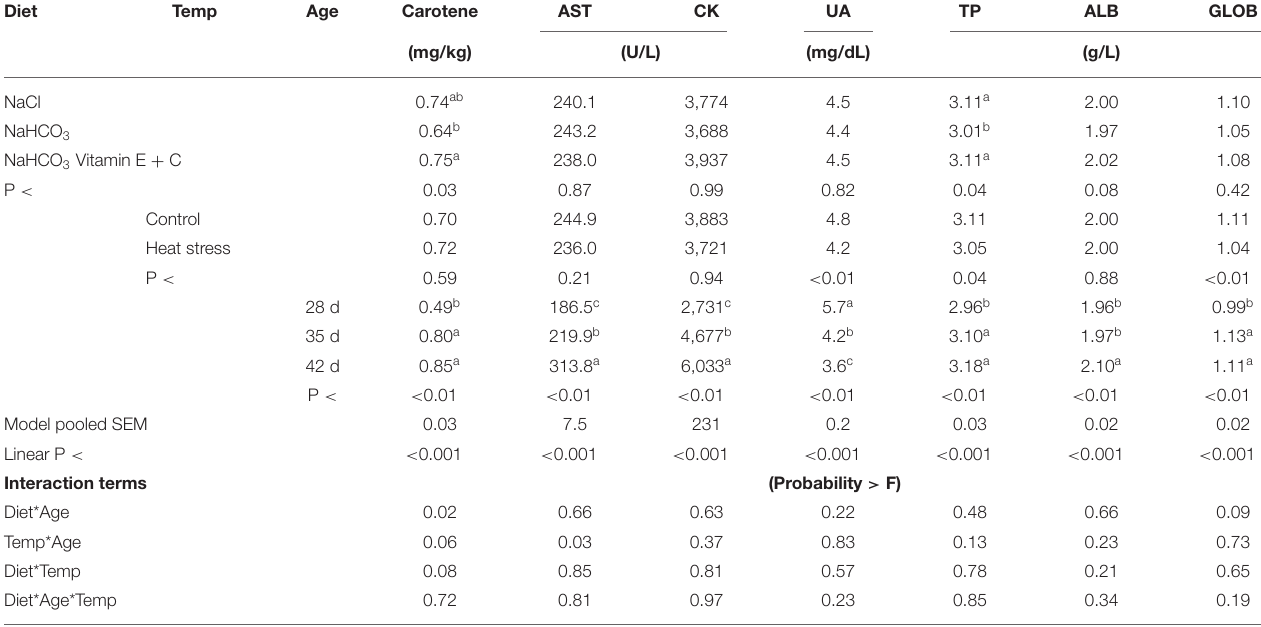
TABLE 4 | Effects of diet, temp and age on broiler blood carotene, aspartate aminotransferase (AST), creatine kinase (CK), bile acids (BA), uric acid (UA), total protein (TP), albumin (ALB), globulin (GLOB).